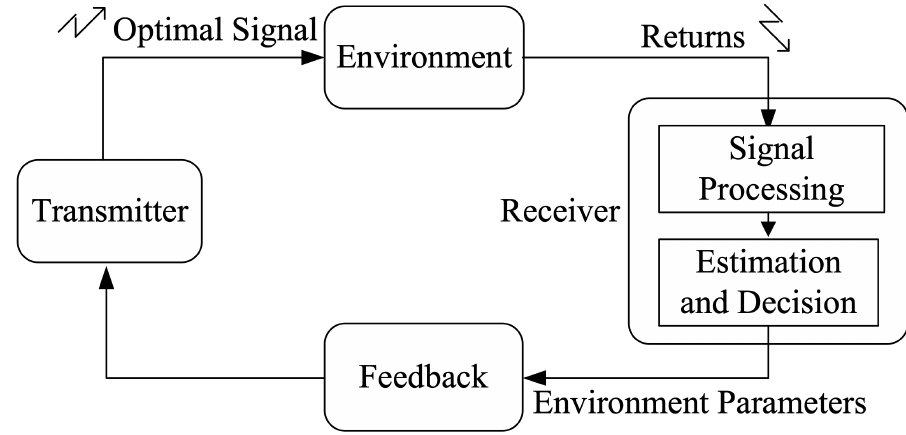
Figure 1. Black diagram of cognitive radar via the feedback